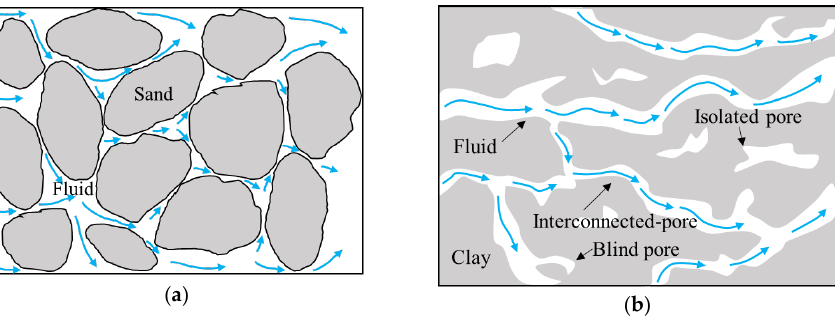
Figure 3. Internal seepage of different soils:( a ) Sand and silty soil; ( b ) Clay.